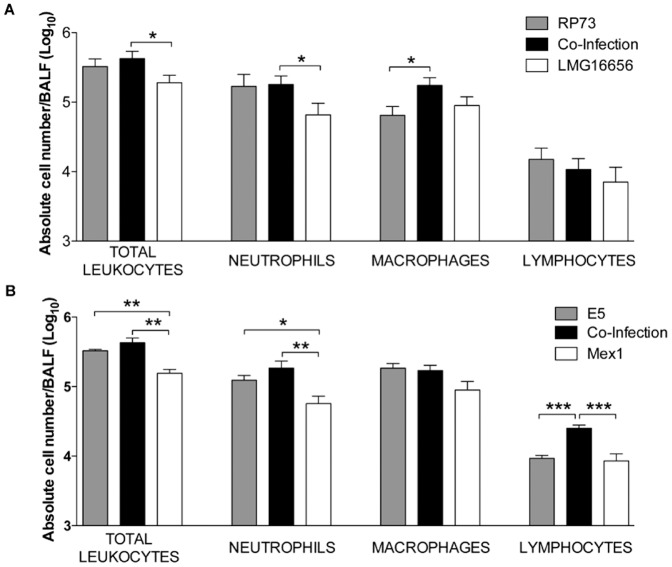
Total and differential cell counts in BAL fluid after 13 days of infection.The number of total leukocytes and in particular of neutrophils, monocytes and lymphocytes recruited in the airways were analyzed in BAL fluid (BALF) after 13 days of chronic lung infection with pairs of clinical (A) or environmental strains (B)). Values represent the mean ± SEM. The data are pooled from two or three independent experiments. Statistical significance by two tailed Student's t-test is indicated: * P<0.05, ** P<0.01.